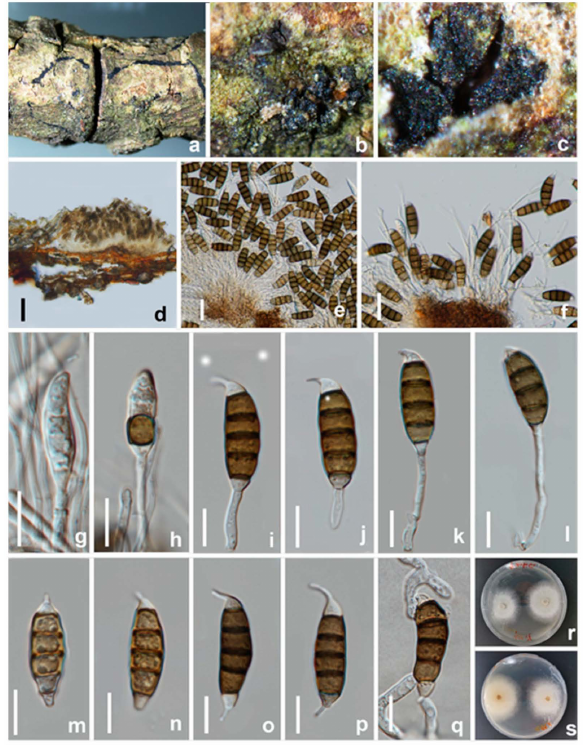
Figure 13. Seiridium guangyuanum (HKAS 123219, holotype) ( a–c ) Appearance of conidiomata on host substrate. ( d ) vertical section of conidiomata. ( e , f ) Sporodochia. ( g – l ) Conidiophore and conidia. ( m – p ) conidia. ( q ) Germinating conidium. ( r , s ) Upper and reverse view of the colony (on PDA). Scale bars: ( d ) = 50 µ m, ( e , f ) = 20 µ m, ( g – q ) = 10 µ